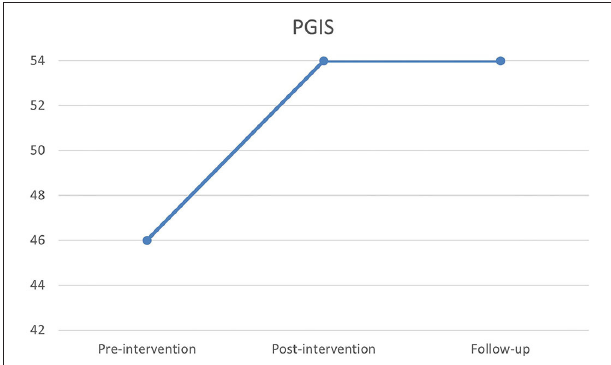
FIGURE 2 | Pre-, post- and follow-up scores on Personal Growth Initiative Scale (PGIS).